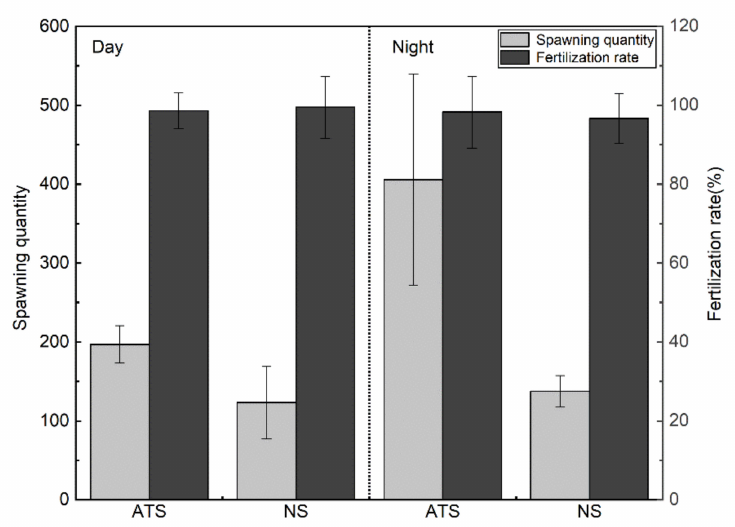
Figure 8. Spawning quantity and fertilization rate of G. przewalskii in artificially transformed substrate and natural riverbed substrate in the day and night. ATS represented the artificially transformed substrate, and NS represented the natural